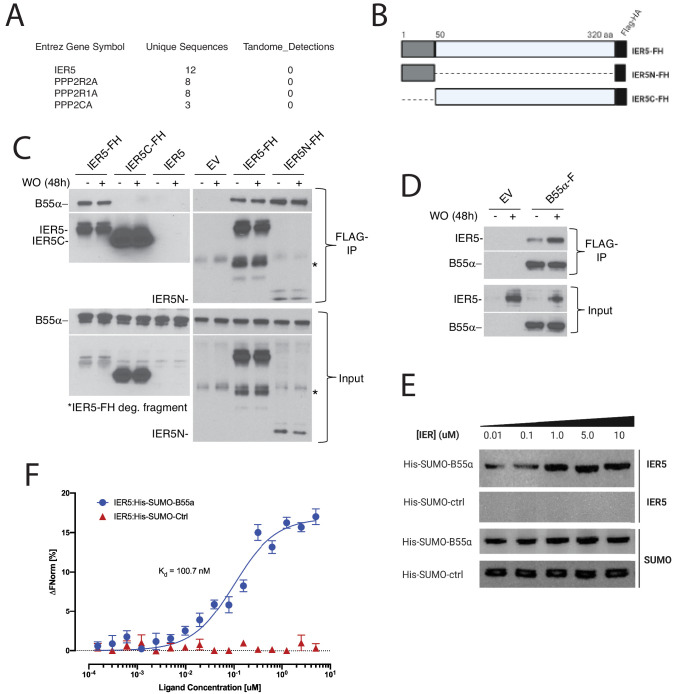
IER5 binds to B55α.(A) Polypeptides identified by mass spectroscopy in immunoprecipitates prepared from I5 cells expressing tandem-tagged IER5. (B) Cartoon showing the structure of tandem-tagged IER5 polypeptides. FH, FLAG-HA tag. (C) Western blot analysis of immunoprecipitates prepared from I5 cells expressing the indicated forms of tagged IER5. WO, washout. (D) Western blot analysis of immunoprecipitates prepared from SC2 cells expressing FLAG-tagged B55α. (E) Western blot showing that IER5 binds His-Sumo-tagged B55α immobilized on beads. The upper two panels were stained for IER5, while the lower two panels were stained for SUMO. (F) Microscale thermophoresis showing saturable binding of IER5 to His-Sumo-tagged B55α.